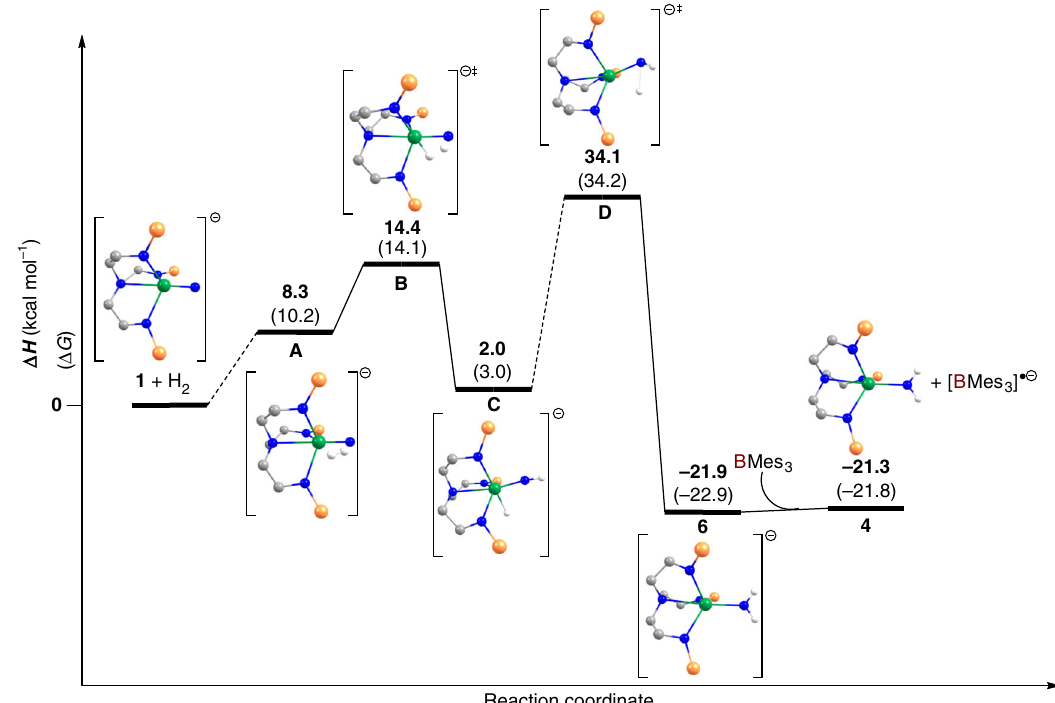
Fig. 9 Computed reaction pro fi le for the conversion of 1 to 6 in the absence of BMes 3 and then conversion to 4 with the addition of BMes 3 . The iso - propyl groups of the silyl substituents, carbon-bound hydrogen atoms, and [K(B15C5 2 )] + cation accommodated in the calculations are omitted for clarity. Bold numbers without parentheses refer to Δ H values and numbers in parentheses are Δ G values, both quoted in kcal mol − 1 .